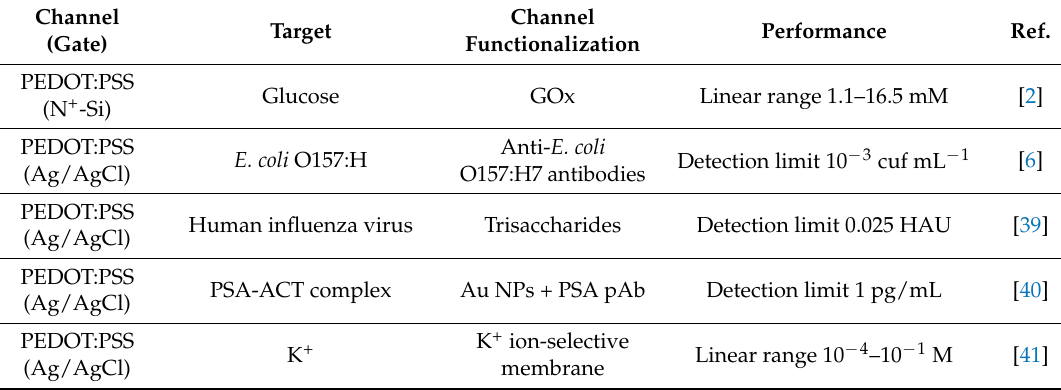
Table 2. Functionalization of OECT channel surface for bioelectric